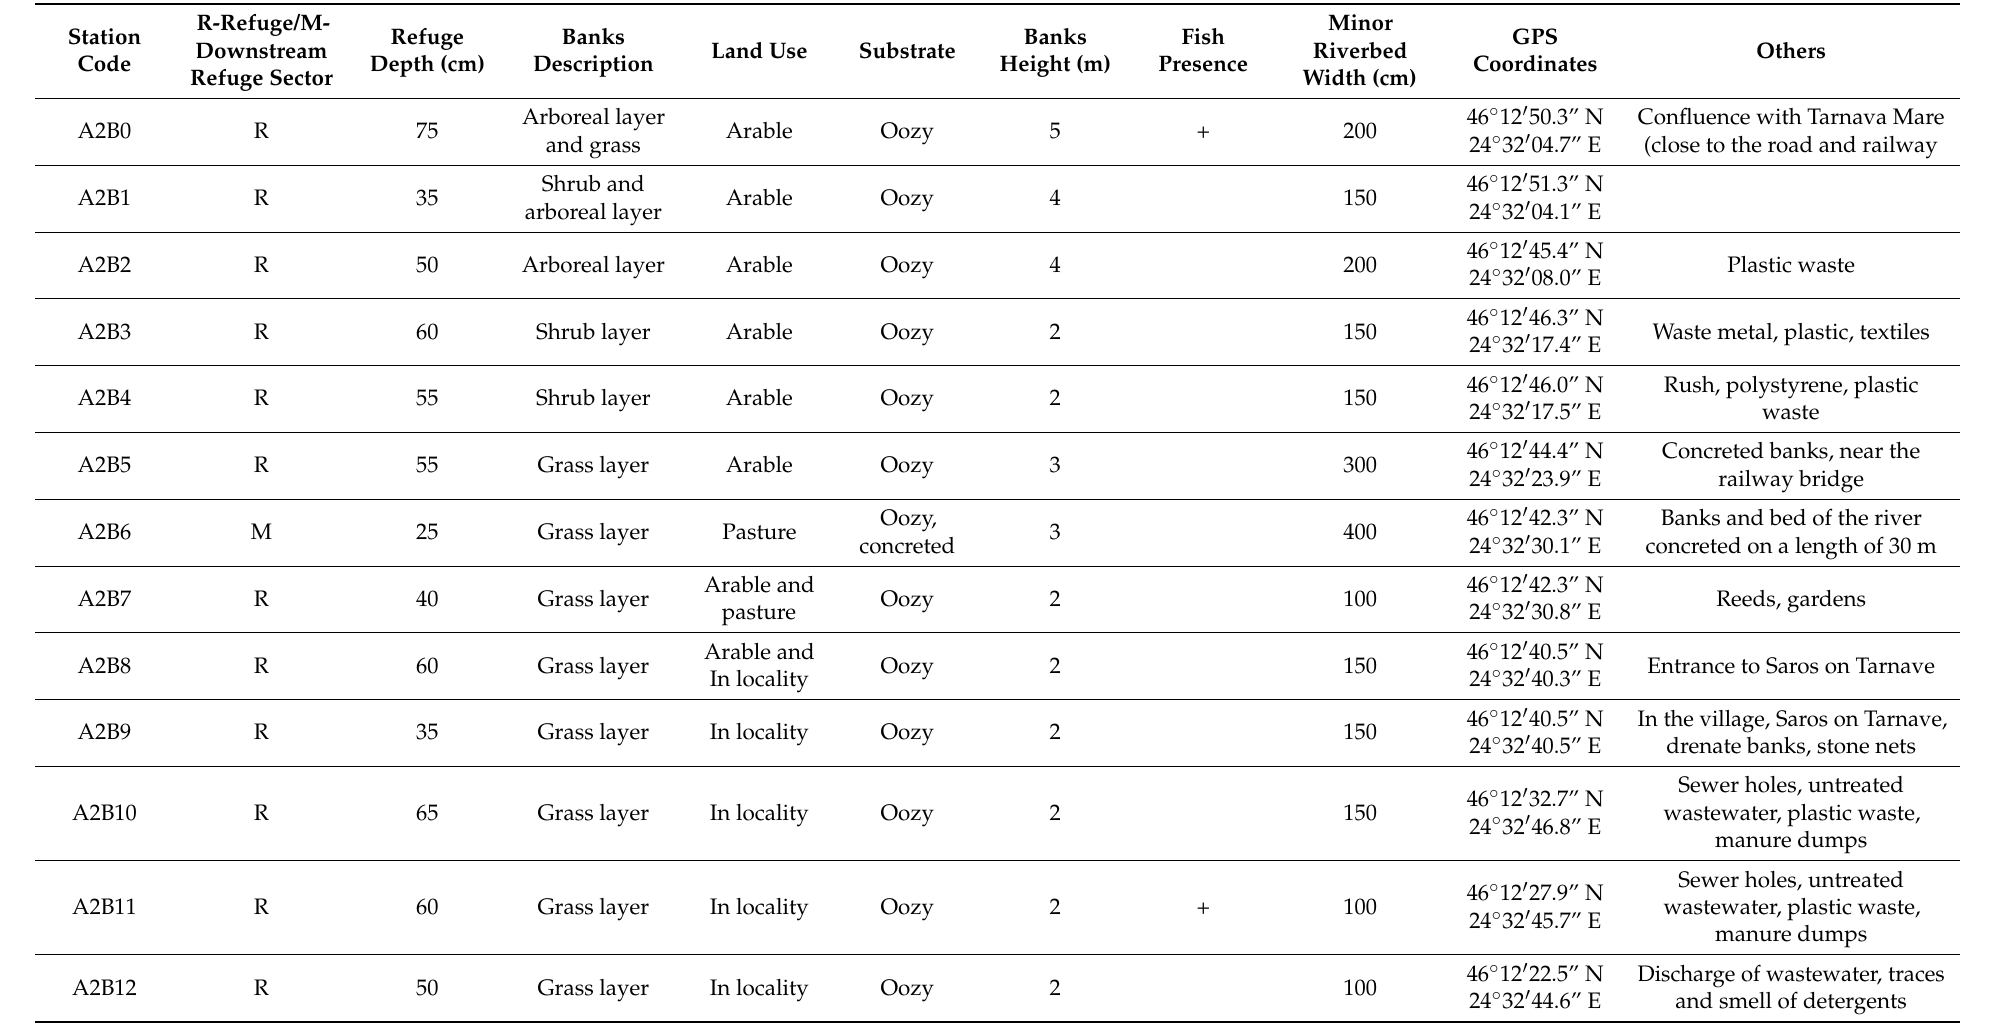
Table A2. Biertan River Habitat